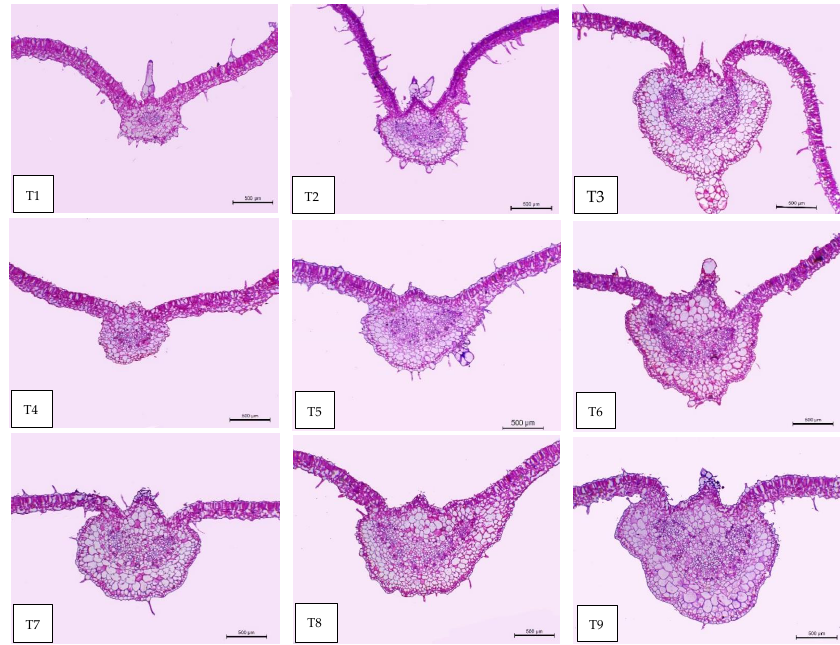
Figure 7. Microphotographs of cross sections through the blade of the terminal leaflet of the fourth compound leaf developed on the main stem of tomato plants, aged 60 days. Scale bars = 500 µm. T1 — self-grafted Peto 86 as a control; T2 — Peto 86/ S. cheesmaniae; T3 — Peto 86/GS hybrid; T4 — Peto 86/Peto 86 + SA; T5 — Peto 86/ S. cheesmaniae + SA; T6 — Peto 86/GS hybrid + SA; T7 — Peto 86/Peto 86 + S. griseus ; T8 — Peto 86/ S. cheesmaniae + S. griseus; T9 — Peto 86/GS hybrid + S. griseus.